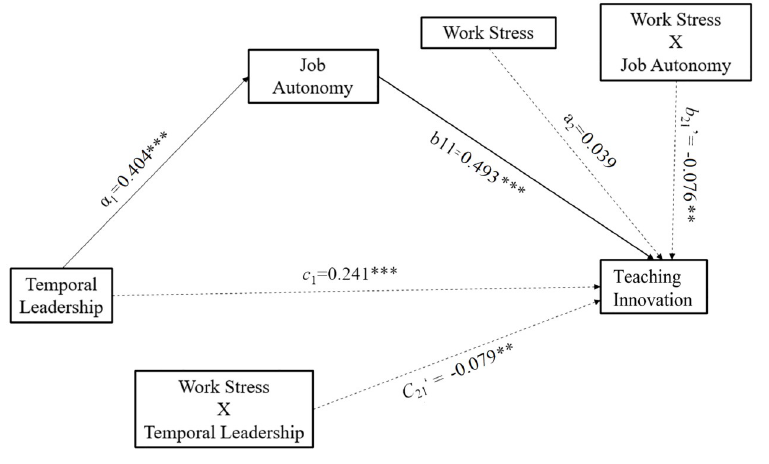
Fig 2. The moderation of work stress. �� p < 0.01, ��� p <